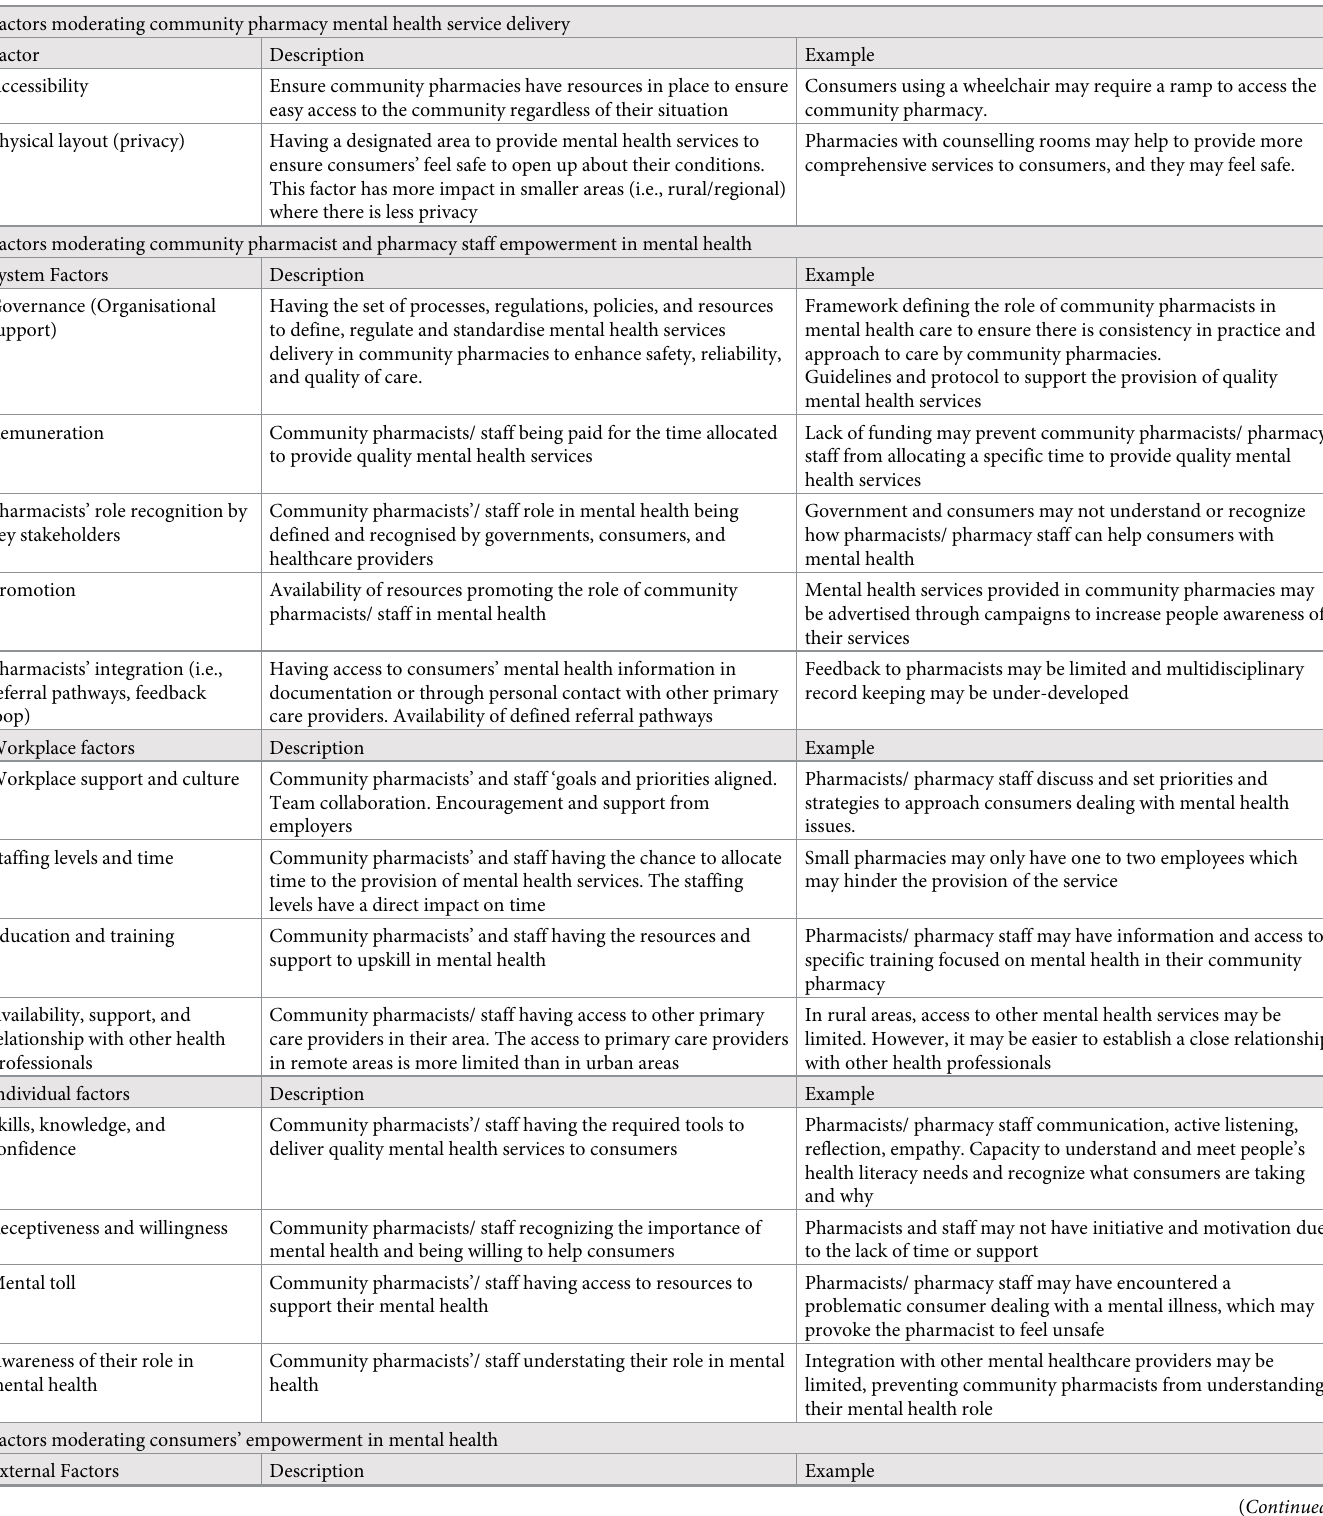
Table 5. Description of factors included in the